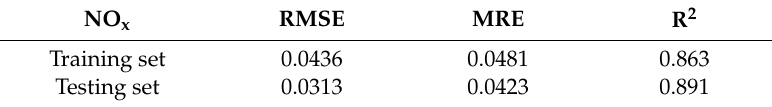
Table 2. Evaluation Index of NO x emission Model Based on IDELM Algorithm.